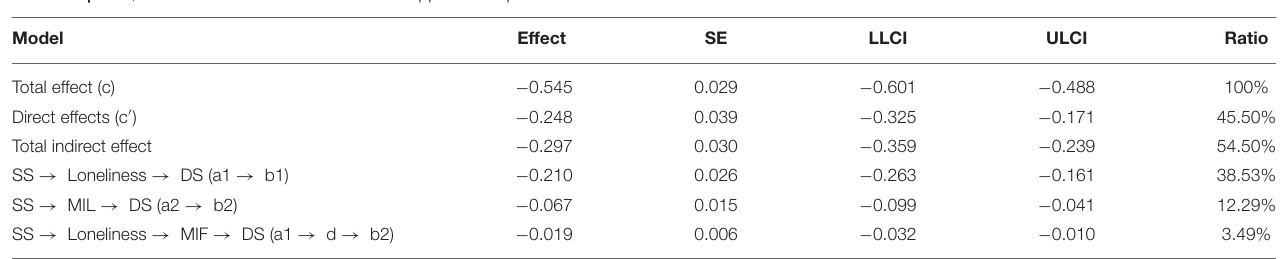
TABLE 4 | Total, direct and indirect effects of social support on depression.